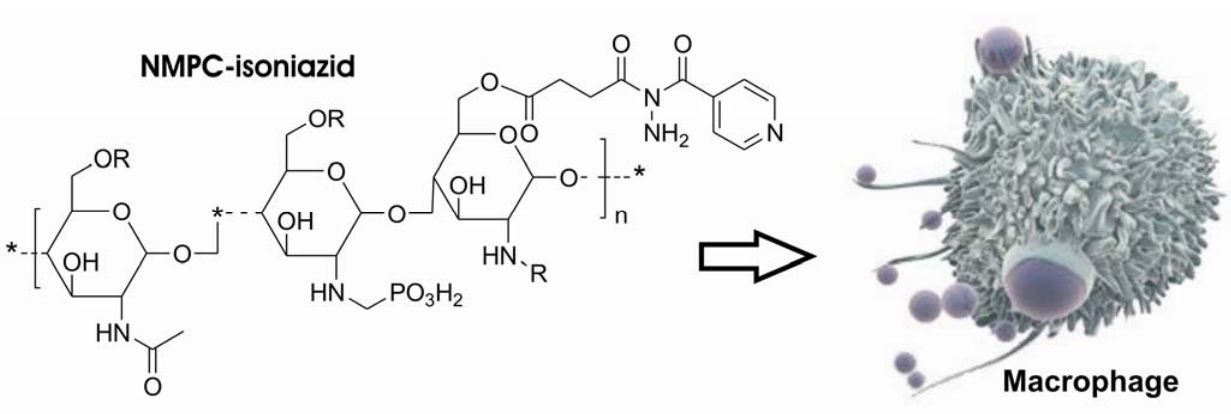
Figure 42. Chitosan-Isoniazid